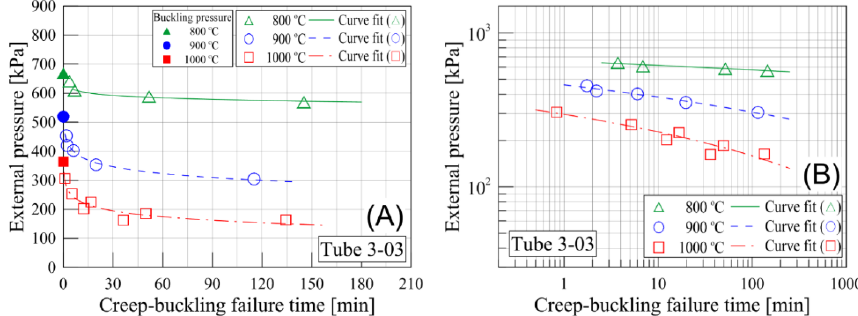
Figure 9. Measurements of the creep-buckling failure for Tube 3-03: ( A ) Linear horizontal axis and ( B ) logarithmic horizontal axis. ( B ) logarithmic horizontal